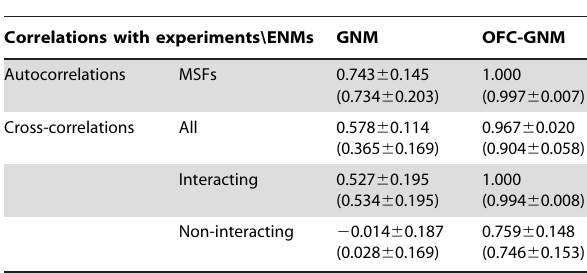
(*) Based on 3649 NMR models from 68 proteins (see Table S1). Values in parenthesis indicate the level of agreement when only the top 5 modes are considered.